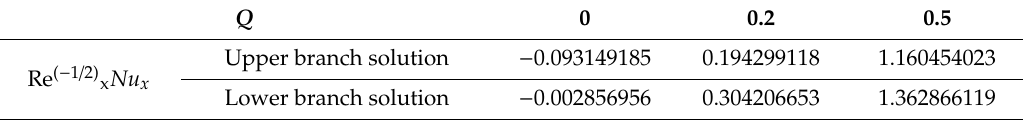
Table 3. Variation of Re ( − 1 / 2) x Nu x with Pr = 1.0, M = 0.1, ε = 1000 and λ = − 1.2. Q 0